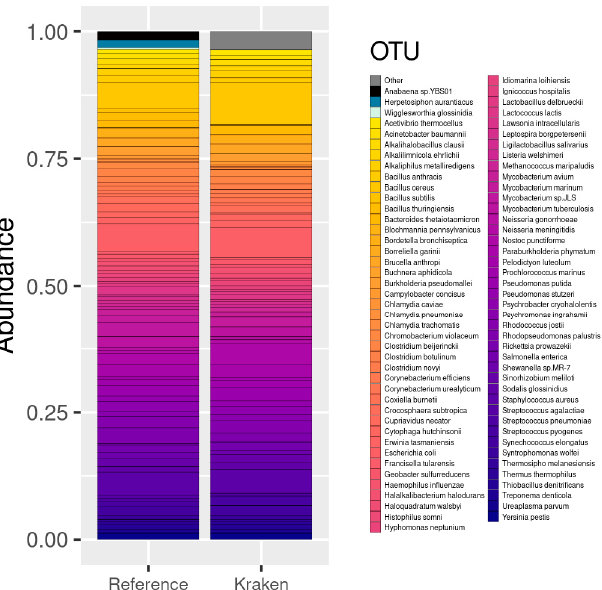
Figure 5. Stacked barplot depicting relative abundance between Reference abundance and Kraken/Bracken pipeline in the 100 species data from Mendo and collaborators . Each vertical bar depicts the relative abundance according to Reference data and Kraken/Bracken pipeline analysis (Kraken bar). Counts associated with false positive OTUs are coloured in grey. A different colour palette was used to represent the reference species not detected by the pipeline. The list of OTUs in the legend is included in Supplementary Table S3.